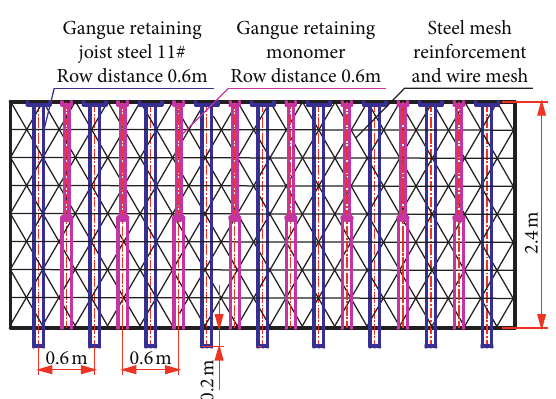
Figure 16: Roadway support section.